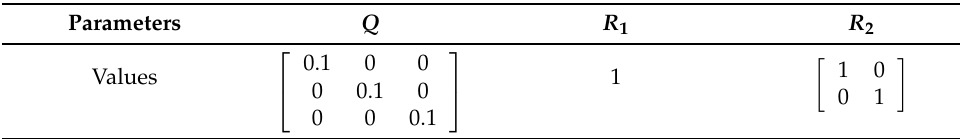
Figure 2. Experimental scenarios. Table 1. Parameters